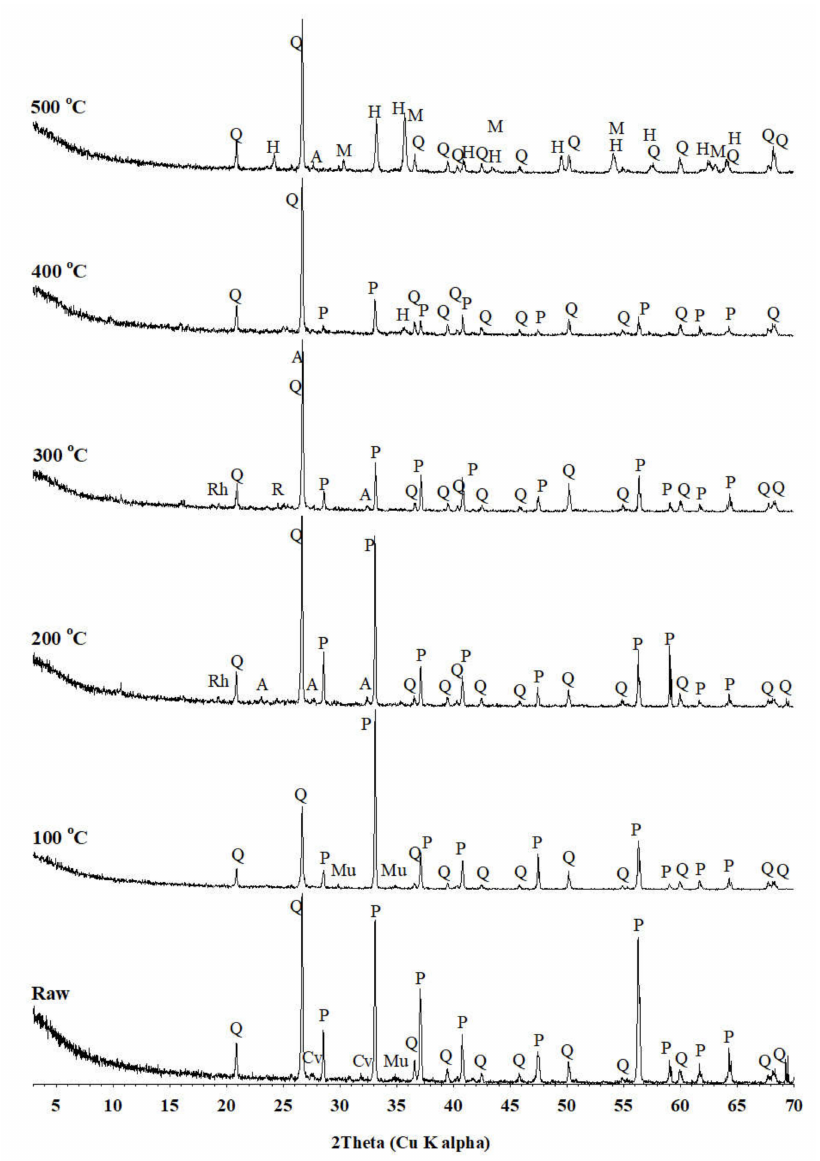
Figure 4. XRD patterns of raw and acid-baked samples in sulfuric acid baking for 3 h. A, anglesite; Cv, covellite; H, hematite; M, magnetite; Mu, muscovite; P, pyrite; Rh, rhomboclase; and Q,